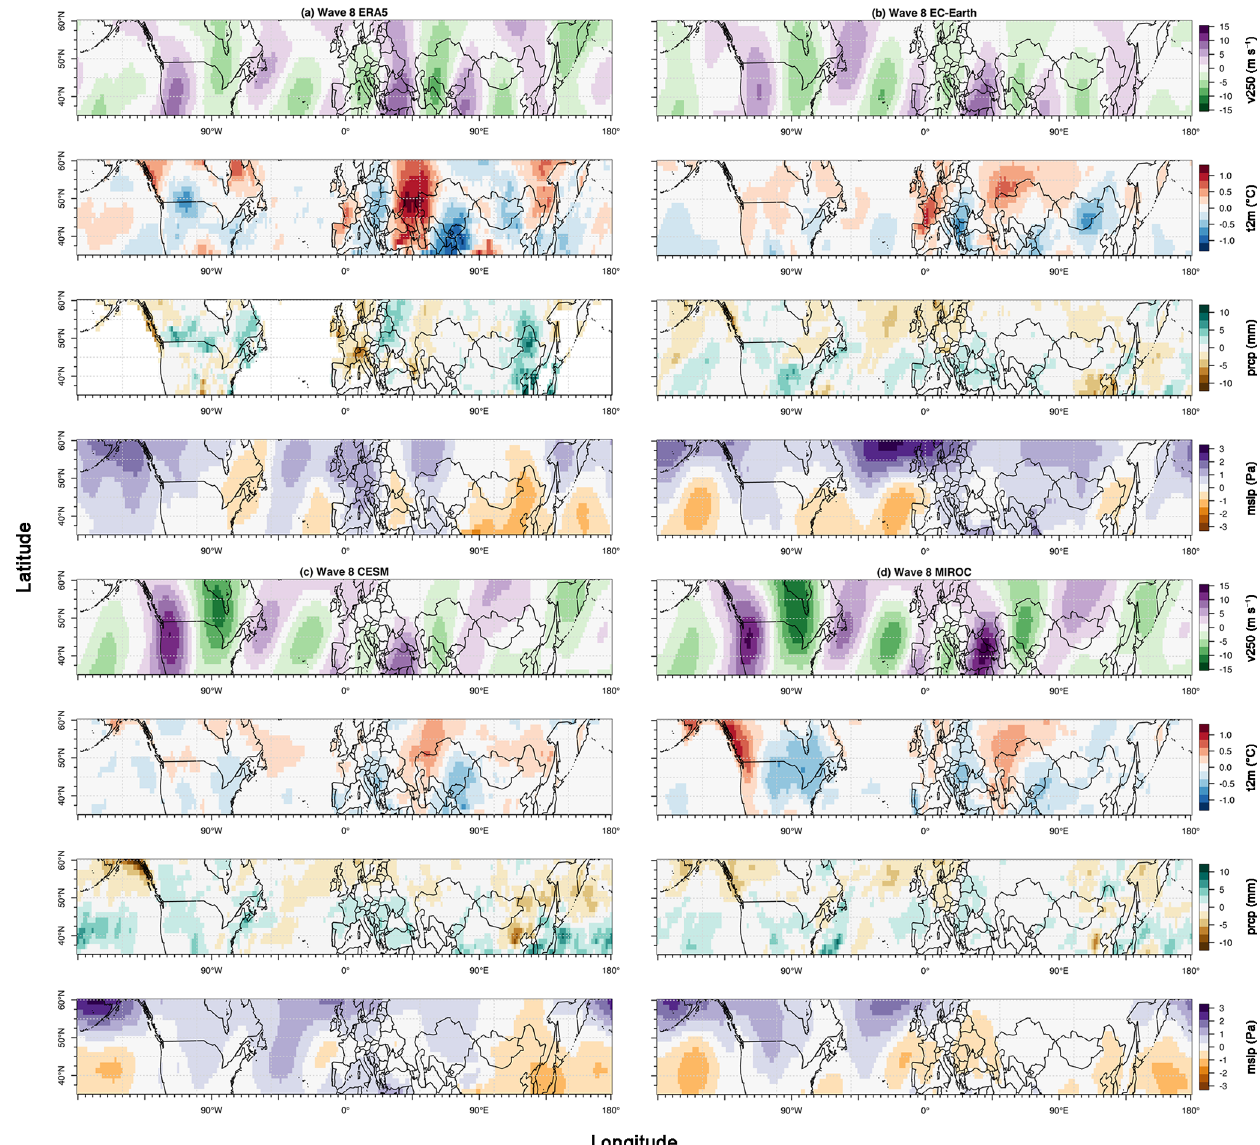
Figure B5. Composite anomaly plots of weeks with high-amplitude wave-8 episodes for meridional wind velocity at 250hPa (v250, absolute field), near-surface temperature (t2m, anomaly), precipitation (prcp, anomaly), and sea level pressure (mslp, anomaly) in ERA5 (a) , EC- Earth (b) , CESM (c) , and MIROC (d) based on the AISI control runs.